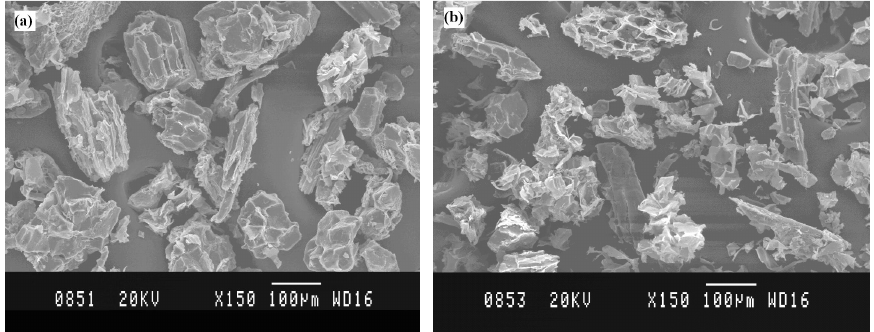
Figure 2 . SEM images of (a) CCS (b) CCS with